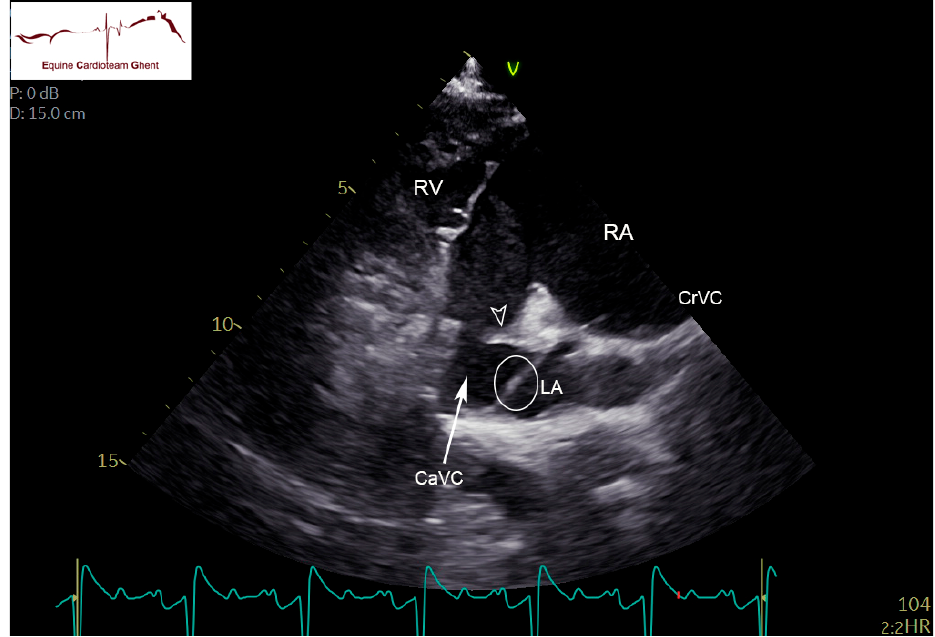
Figure 2. Septum primum ( circle ) and limbus ( arrowhead ) in a 2-day-old healthy foal visualized on a right parasternal oblique view obtained by rotating the ultrasound probe towards two o’clock and angulating dorso-caudally). CaVC: cranial vena cava, CrVC: cranial vena cava, LA: left atrium; RA: right atrium; RV: right ventricle.